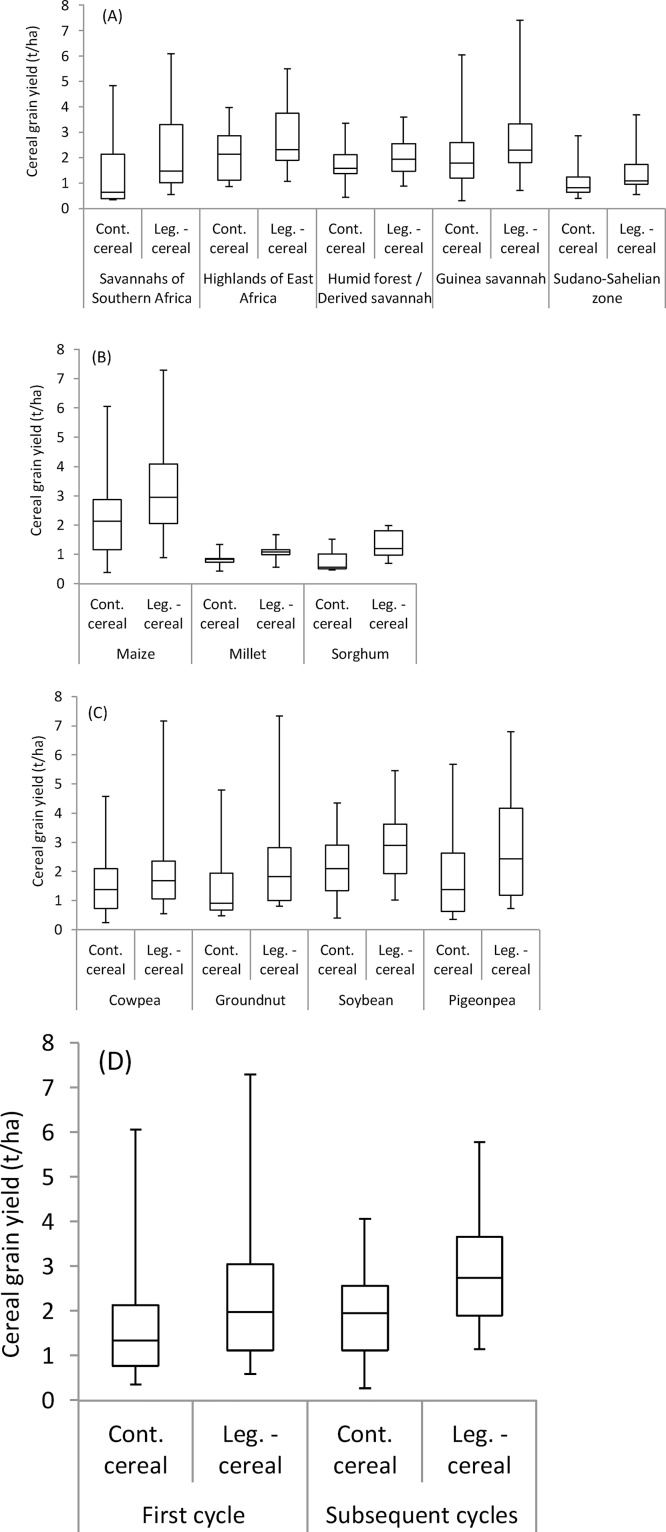
Box plots of cereal grain yield in continuous (cont.) cereal and legume (leg.)-cereal rotations separated by (A) the main agro-ecological zones, (B) cereal type, (C) legume type and (D) the number of rotational cycles. The whiskers represent the 2nd and 98th percentile of the observations.